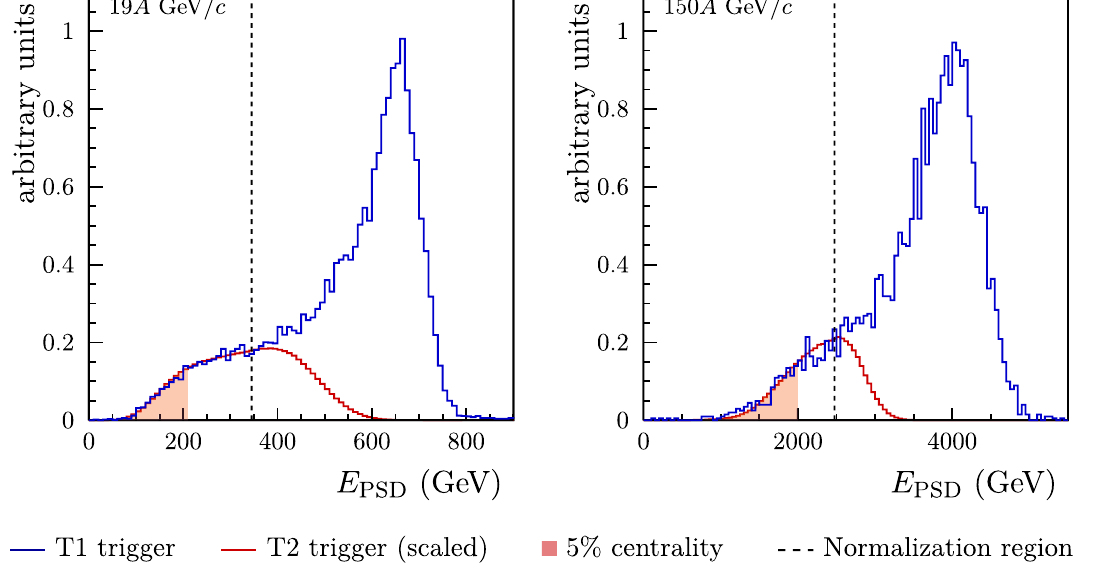
Epos WNMandGlissandoarefor centrality selectionusingthesmallest number of spectators, whereas the Epos E F results are obtained using the forward energy E F within the acceptance map in Ref. [22]. The last line presents numerical values of the c cent